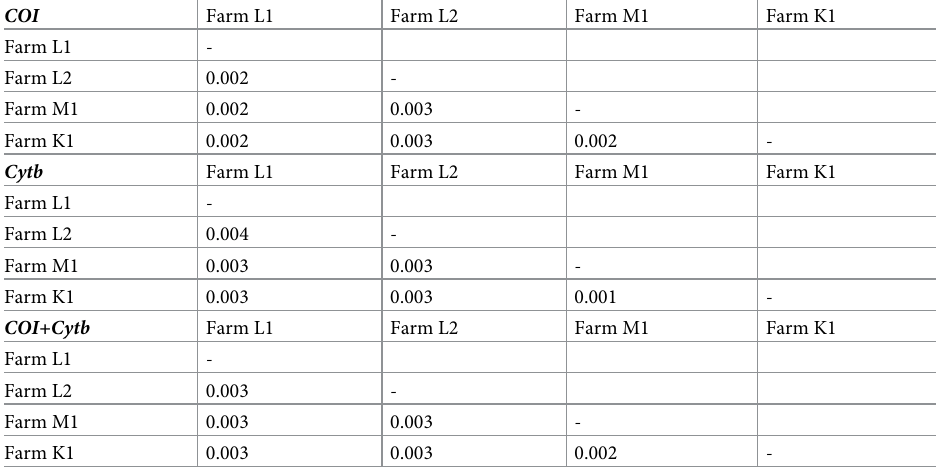
Table 4. Uncorrected “p” distance matrix between different locations based on COI, Cytb and COI+Cytb DNA sequences of Bathycoelia distincta from South Africa. COI Farm